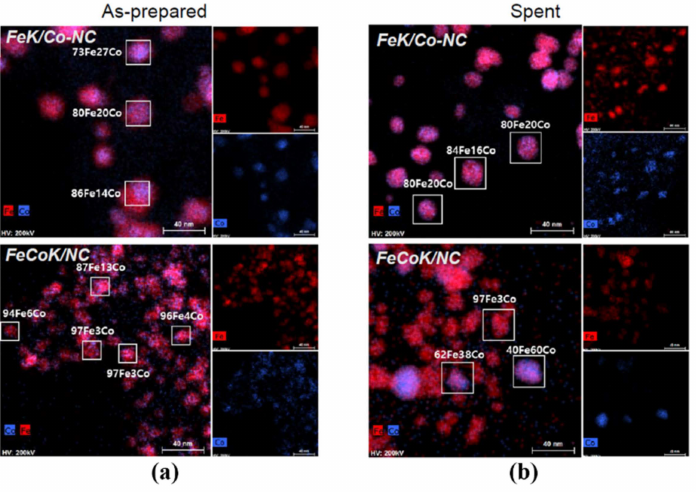
Figure 2. TEM-EDS mapping images of ( a ) as-prepared FeK/Co-NC and FeCoK/NC and ( b ) spent FeK/Co-NC and FeCoK/NC catalysts after reaction for 70 h. Reprinted with permission from Hwang et al. [36]. Copyright (2021) American Chemical Society.